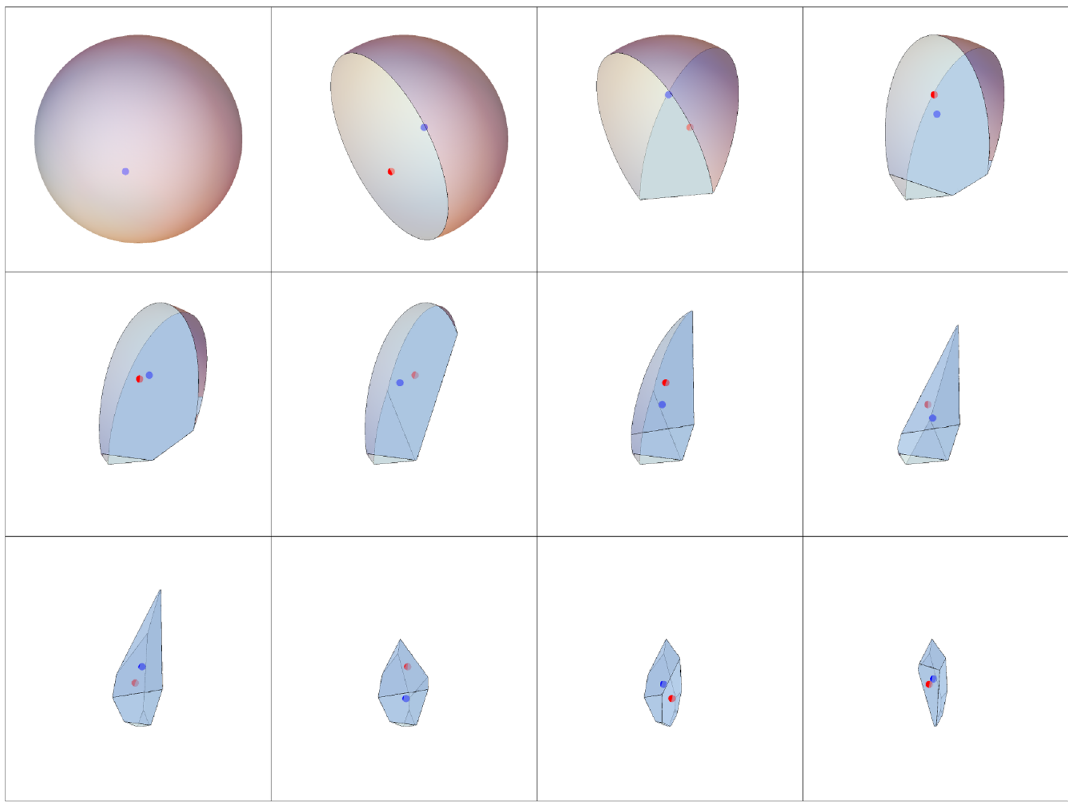
Figure 3 . Example allowed regions A 1 ; : : : ; A 12 of OPE space during the cutting surface algorithm for scanning over OPE coe(cid:14)cients. This example is drawn from our calculation of the O(2) model island with derivative order (cid:3) = 43. We plot OPE space after applying the a(cid:14)ne transformation described in (cid:12)gure 4, which turns the initial bounding ellipsoid into the unit sphere. For each allowed region A n , we show the point [ (cid:21) n ] most recently ruled out by SDPB in red. This point is typically very close to the boundary of the allowed region. We also show the next point to be tested [ (cid:21) n +1 ] in blue. We choose the blue point close to the center of A n . In the (cid:12)nal frame, SDPB gives primal feasible for the blue